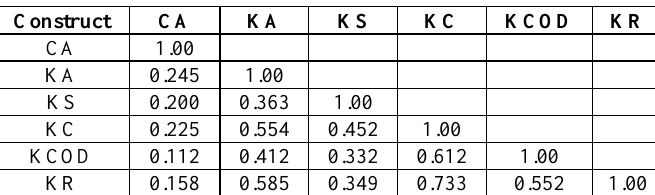
Table 6: Discriminant Validity for Each